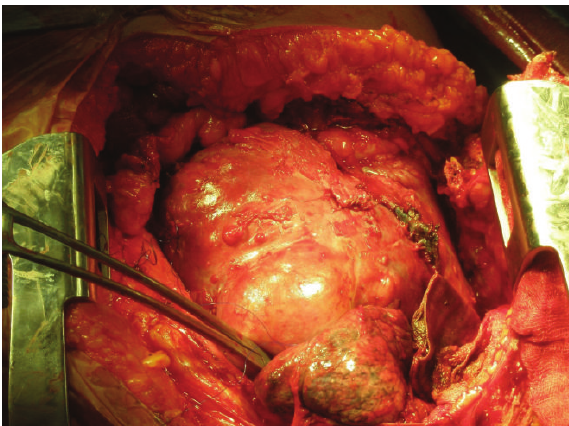
Figure 2: Solitary fibrous tumor which filled the entire hemithorax causing mediastinal shift.